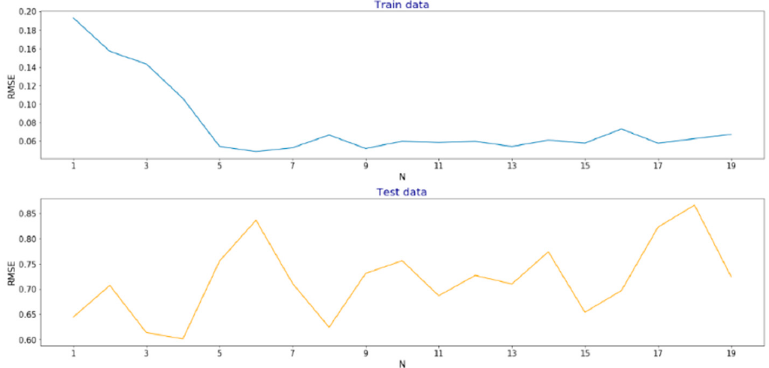
Table 8. RMSE of train and test data according to N and node value of LSTM algorithm.